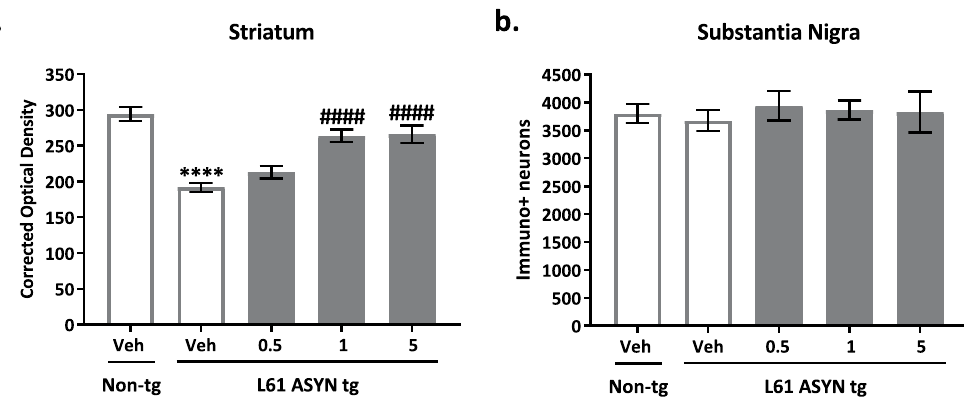
Figure 8. NPT200-11 administration results in normalized striatal tyrosine hydroxylase (TH) immunolabeling in Line 61 ASYN transgenic mice. There was a statistically significant decrease in tyrosine hydroxylase immunolabeling in ( a ) the striatum ( **** p < 0.0001 vs. vehicle-treated non-transgenic controls ), but not in the ( b ) substantia nigra of Line 61 ASYN transgenic mice. NPT200-11 administration (1 & 5 mg/kg) produced a statistically significant normalization in tyrosine hydroxylase immunolabeling levels in the (a) striatum of Line 61 transgenic mice ( 1 and 5 mg/kg at #### p < 0.0001 vs. vehicle-treated Line 61 ASYN transgenic controls ). There were no statistically significant effects of NPT200-11 treatment on ( b ) the number of immunopositive neuronal cell bodies in the substantia